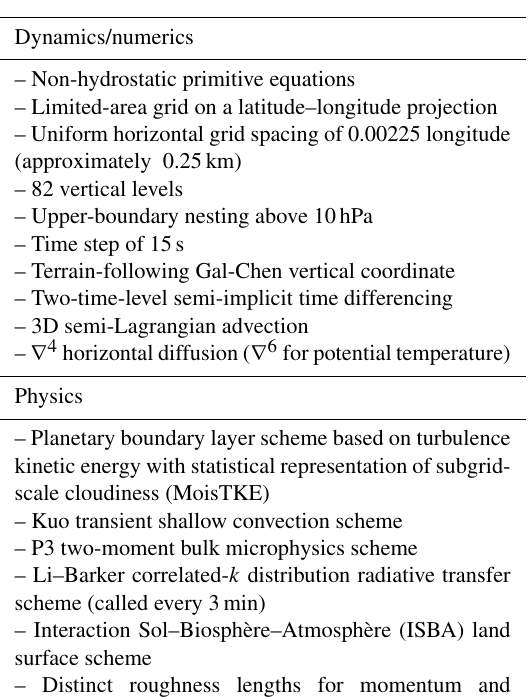
Table 1. Summary of the GEM model configurations’ details. Ref- erences to specific schemes are provided in Milbrandt et al. (2016).